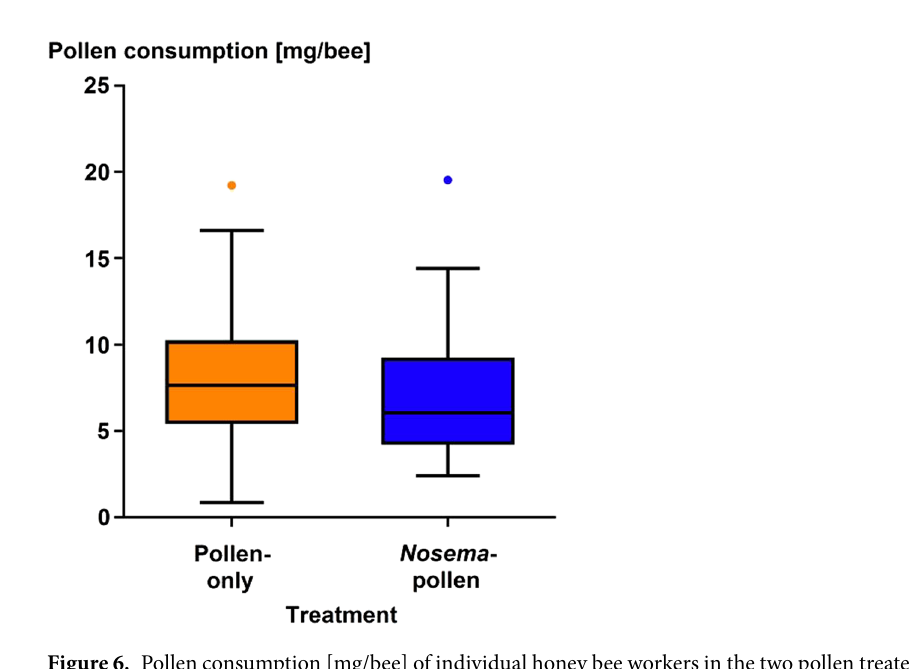
Figure 6. Pollen consumption [mg/bee] of individual honey bee workers in the two pollen treated groups (Pollen-only [orange], Nosema -pollen [blue]). Medians, ranges, confidence intervals and outliers ( = dots) are shown. Workers contaminated with N. ceranae from the pollen-only treatment are not considered. No significant differences were found between the Pollen-only and the Nosema -pollen group (P >